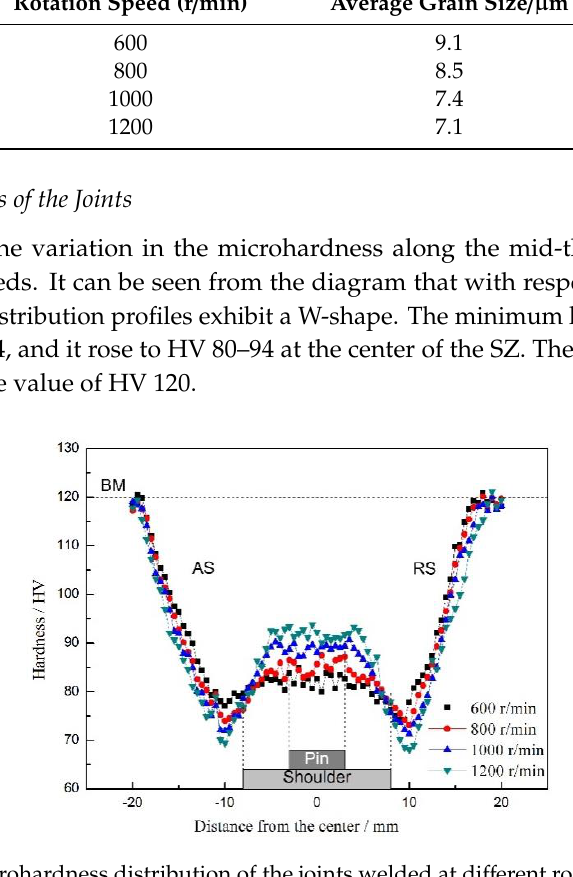
Figure 11. Tensile properties of the joints at different rotational speeds.